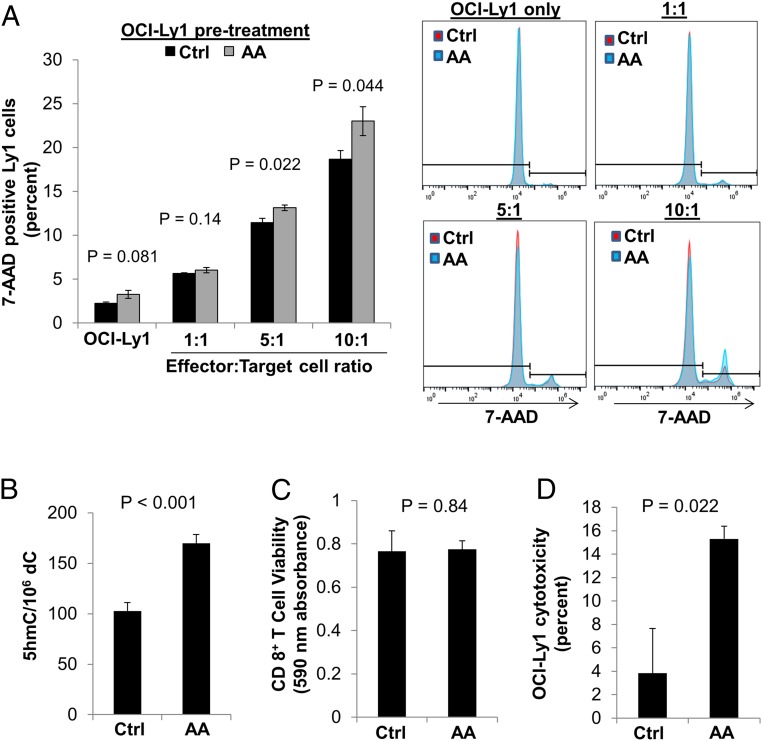
Pretreatment of both lymphoma cells or CD8+ T cells with AA enhances T cell-mediated lymphoma cell cytotoxicity. (A) Pretreatment of OCI-Ly1 B cell lymphoma cells with AA did not significantly affect B cell viability (P = 0.081) but increased immunogenicity in a T cell cytotoxicity assay (5:1 T:B cell ratio, P = 0.022; 10:1 ratio, P = 0.044). OCI-Ly1 cells were pretreated with control (Ctrl) or AA for 6 h. OCI-Ly1 cells (target cells) were then suspended in fresh medium with specified ratios of CD8+ T cells (effector cells) and incubated for 48 h. OCI-Ly1 cytotoxicity was measured by 7-AAD positive staining in OCI-LY1 cells. Each condition was performed in triplicate and representative flow cytometry is shown. (B) AA significantly increased 5hmC in CD8+ T cells compared to Ctrl (P < 0.001, paired t test) as measured by MS. CD8+ T cells isolated from 3 normal donors were treated with Ctrl or AA for 6 h and cells were harvested at 24 h after treatment. (C) Treatment of CD8+ T cells with AA for 6 h had no impact on T cell viability 24 h after treatment (P = 0.84) as measured by Alamar Blue cell viability assay. (D) Pretreatment of CD8+ T cells with AA increased B cell lymphoma cytotoxicity (P = 0.022) as measured by LDH cytotoxicity assay. CD8+ T cells were pretreated with Ctrl or AA for 6 h, then CD8+ T cells were combined with OCI-Ly1 cells in a 1:1 ratio for 24 h. Data are expressed as means ± SEM.